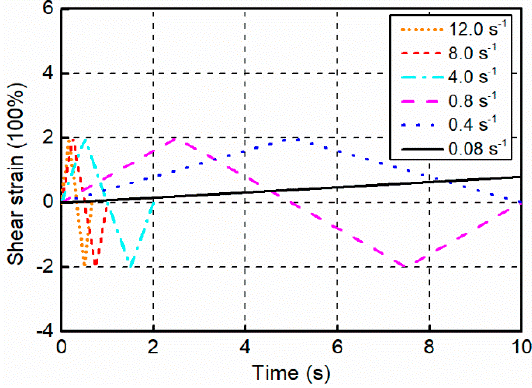
Figure 9. Applied strain histories in the cyclic shear tests.